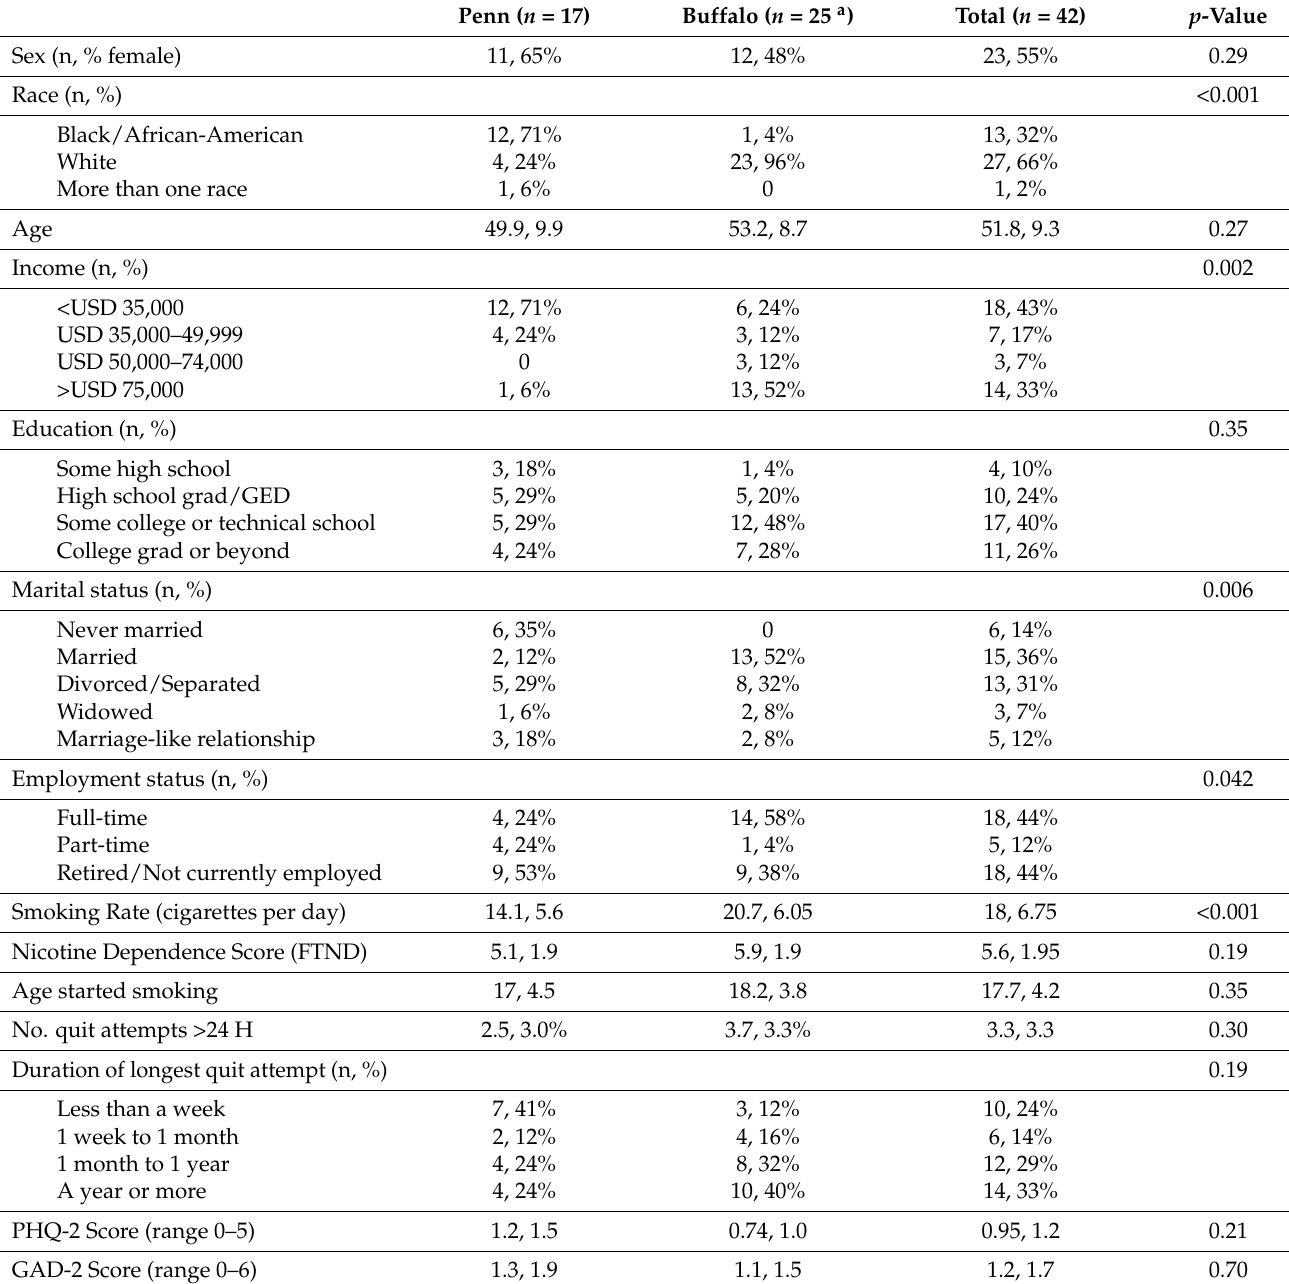
Table 1. Demographics and smoking characteristics across both sites ( n =